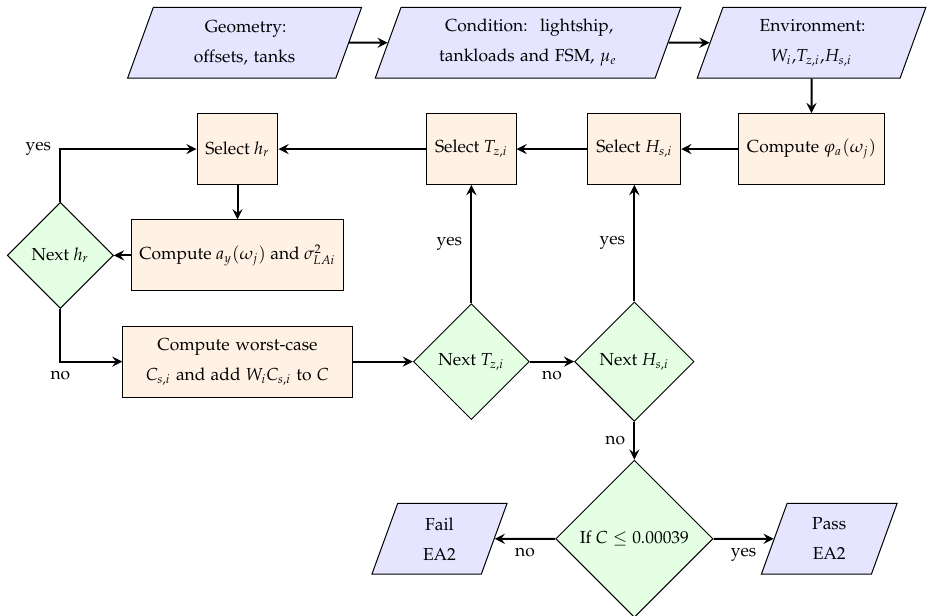
Figure 8. Excessive acceleration level 2 algorithm process